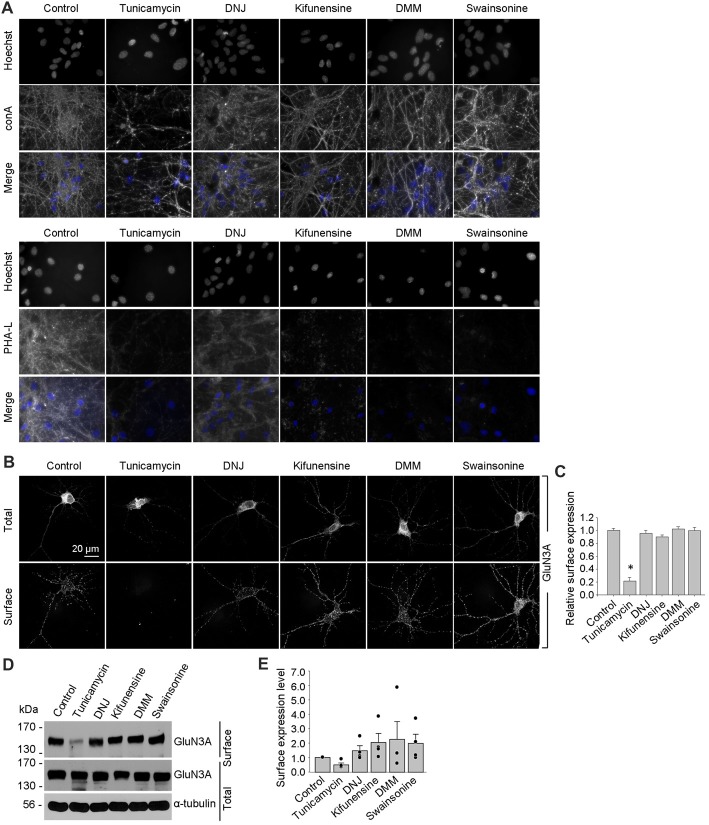
Tunicamycin, but not inhibitors of later step in the N-glycosylation pathway, reduces the surface delivery of GluN3A subunits in hippocampal neurons. (A) Hippocampal neurons were treated for 2 days with 0.5 μg/ml tunicamycin, 200 μg/ml DNJ, 5 μg/ml kifunensine, 200 μg/ml DMM, or 100 μg/ml swainsonine. The neurons were then labeled with fluorescently tagged conA or PHA-L and Hoechst 33342 (Hoechst); representative examples are shown. (B) Hippocampal neurons were transfected with GFP-GluN3A (GluN3A) at DIV8 and treated for 2 days with the indicated inhibitors as described above. The neurons were then immunostained for surface and total GFP under non-permeabilizing and permeabilizing conditions, respectively; representative images of total and surface immunoreactivity are shown. (C) Summary of the relative surface expression of GluN3A subunits in neurons treated with the indicated inhibitors; data were obtained from 10-μm long segments of secondary and tertiary dendrites (n ≥ 30 segments from ≥6 neurons) and are expressed relative to control-treated neurons; *p < 0.05 vs. control (ANOVA). (D) A surface biotinylation assay was performed at DIV15 on dense cultures of hippocampal neurons treated for 2 days with the indicated inhibitors applied at the concentrations described above. (E) Graph of the relative surface expression measured using the surface biotinylation assay shown in (D); the intensity of the surface and total GluN3A bands were quantified using ImageJ; the black dots indicate the values obtained in the individual experiments; n = 4. *p < 0.05 vs. control (Student’s t-test).